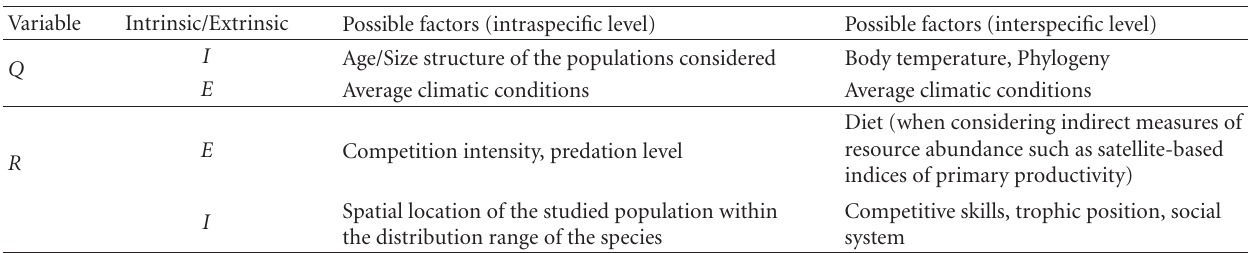
Table 1: Possible factors a ff ecting the strength of the energy/abundance relationship at both the intraspecific and interspecific levels. Q refers to the consumer resource requirements, R refers to the resource supply rate, I refers to intrinsic factors (e.g., biological traits), while E stands for extrinsic factors (e.g., environmental